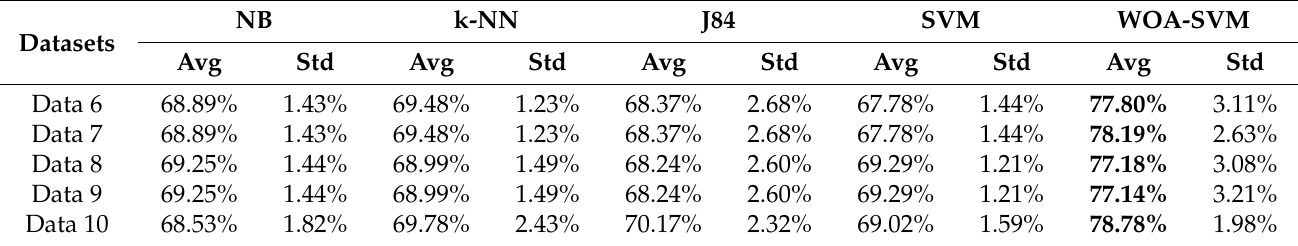
Table 5. Accuracy results of standard classifiers against WOA-SVM for Latter-rules